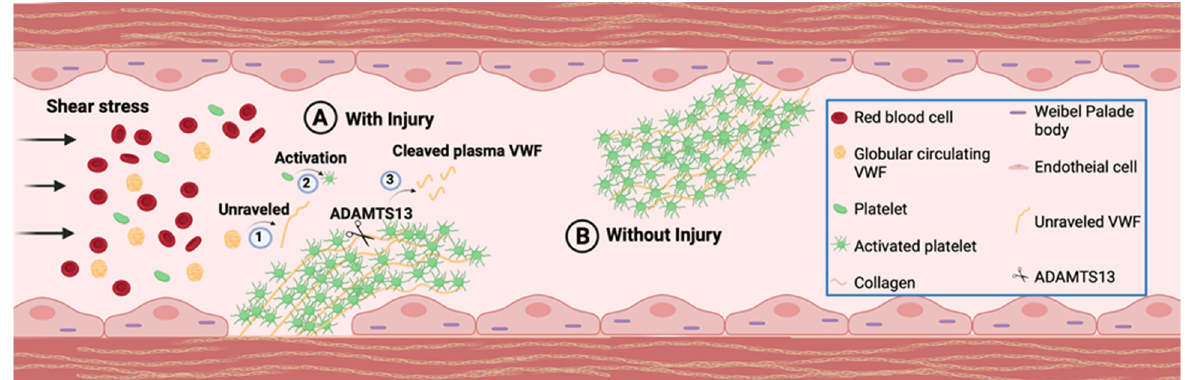
Figure 1. VWF Function. VWF is stored in Weibel-Palade bodies (WPB) and deposited in extracellular matrix of vascular endothelial cells, as well as circulating in plasma as globular form. ( A ) At the site of injury in presence of shear stress globular VWF attach to the exposed subendothelial collagen layer and (1) unravel to form the most adhesive form of VWF. The extracellular matrix deposited VWF is similarly exposed to bind platelets. Platelets captured by unraveled VWF are (2) activated and form VWF-platelet aggregates to seal the damaged vessel wall and prevent blood leakage while repair. Following the completion of repair process ADAMTS13 (Scissors) will (3) cleave UL VWF to smaller VWF multimers to resolve platelet aggregates. ( B ) External stimuli induce secretion of VWF, which may bind to endothelial luminal surface membrane and mediate platelet aggregate formation through a similar process as that observed at the site of vascular injury.